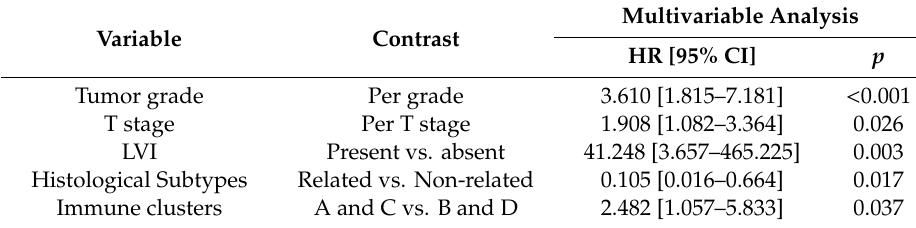
Table 4. Multivariate logistic regression analysis of immune clusters associated with